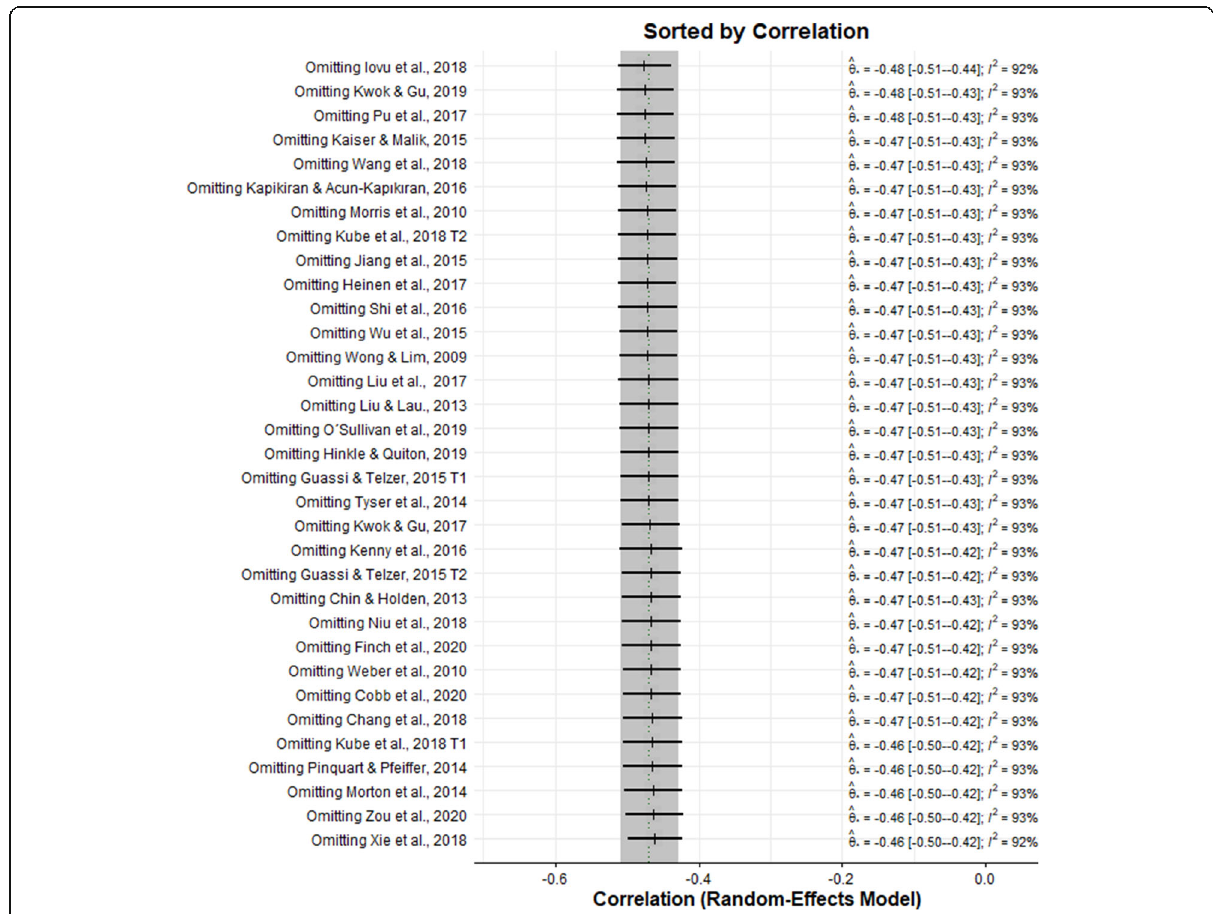
Fig. 5 Results of the sensitivity analysis of leaving one out. Sensitivity analysis on the correlation between dispositional optimism and depression. The result that leaving out a study is represented by a combined correlation estimate with 95%